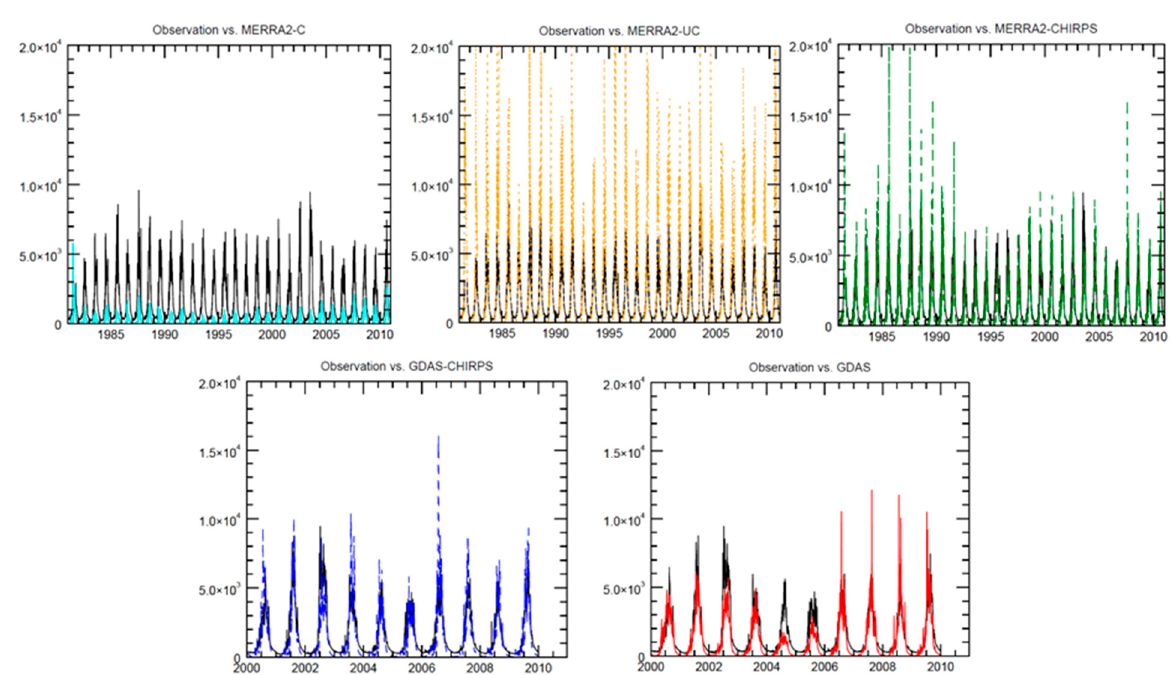
Figure 11. Comparison between daily observed and model streamflow (m 3 /sec) at Chattara (Nepal).